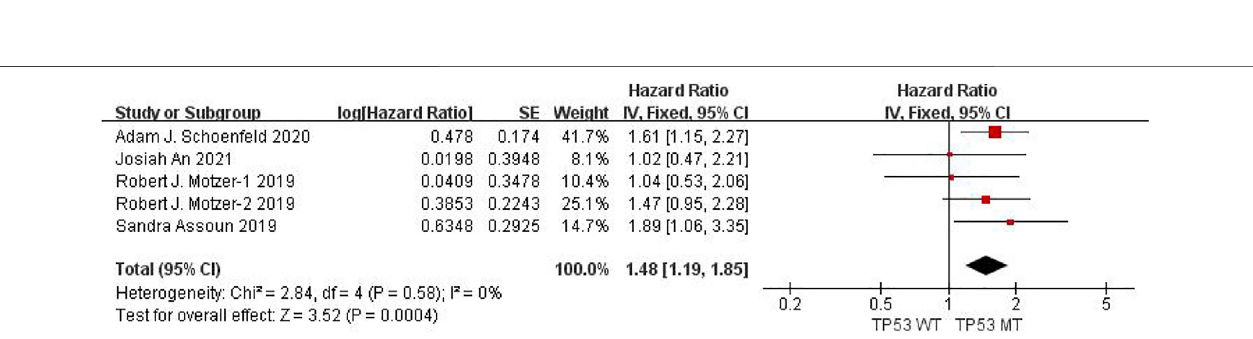
Frontiers in Pharmacology |